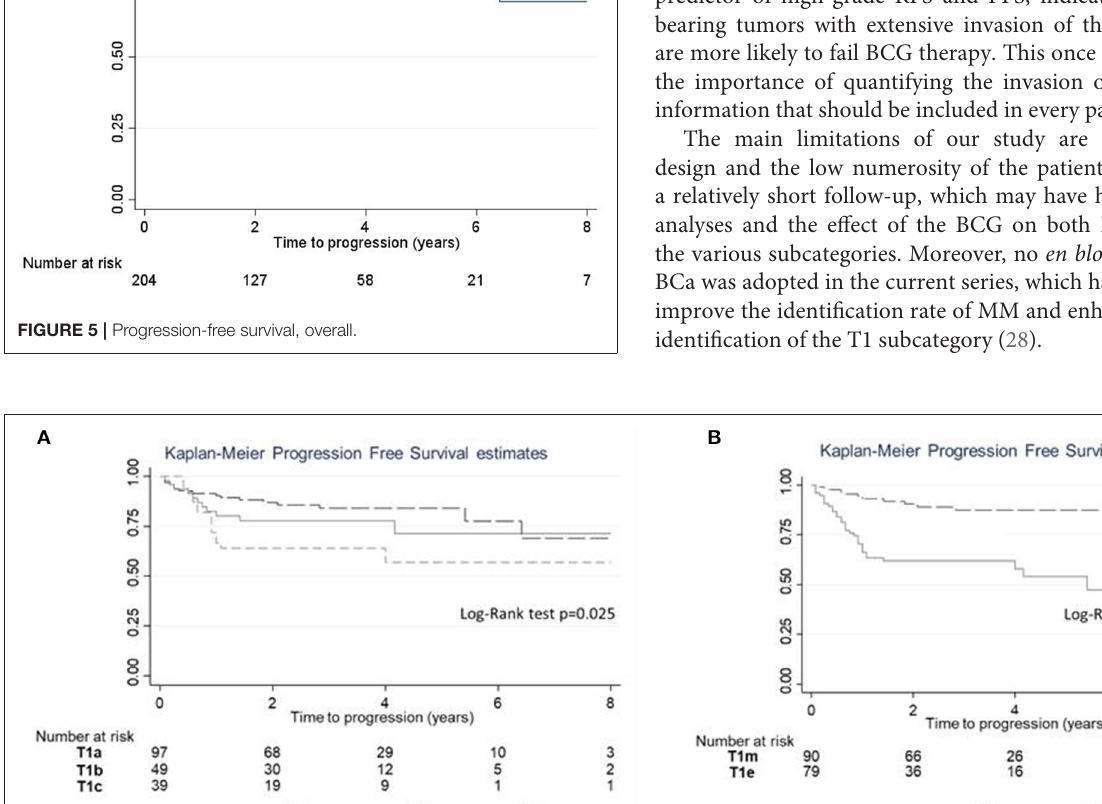
Frontiers in Surgery |